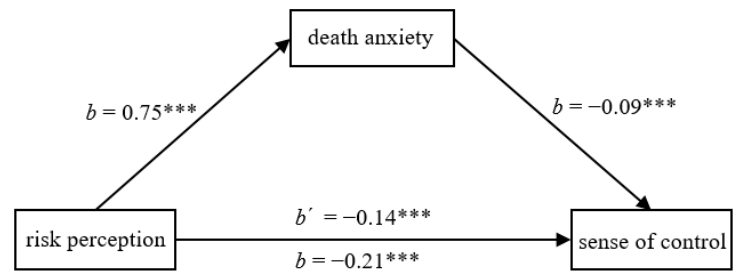
Figure 5. Death anxiety partially mediated the effect of risk perception on sense of control in Study 5. *** p < 0.001.